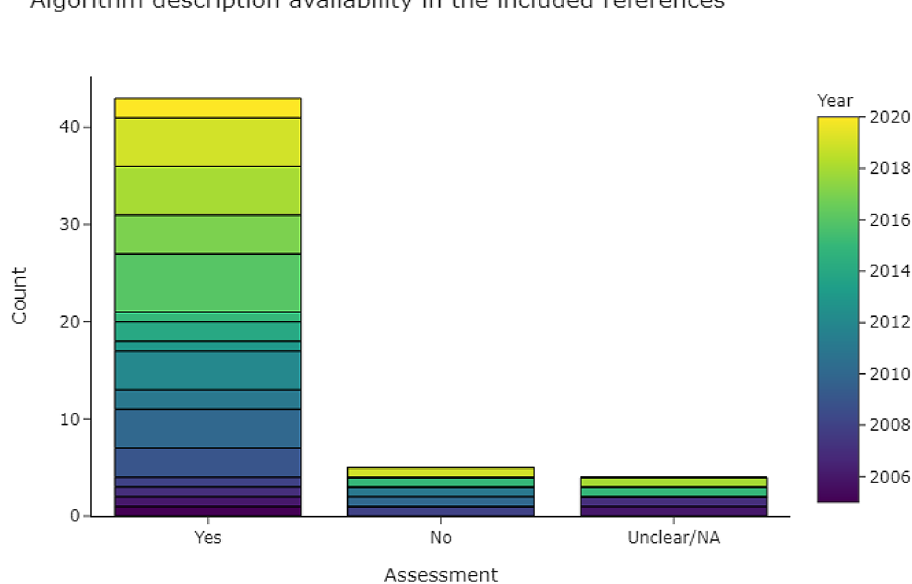
Figure 8. Bar chart, showing the levels of algorithm description in the included